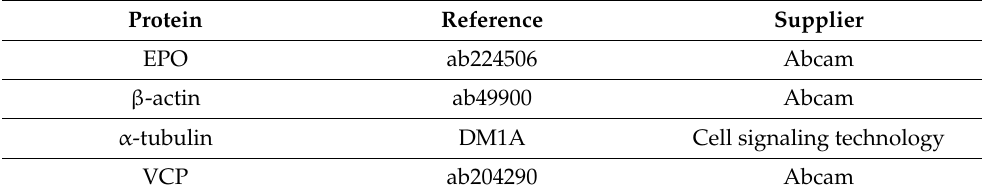
Table 2. List of antibodies used for Western